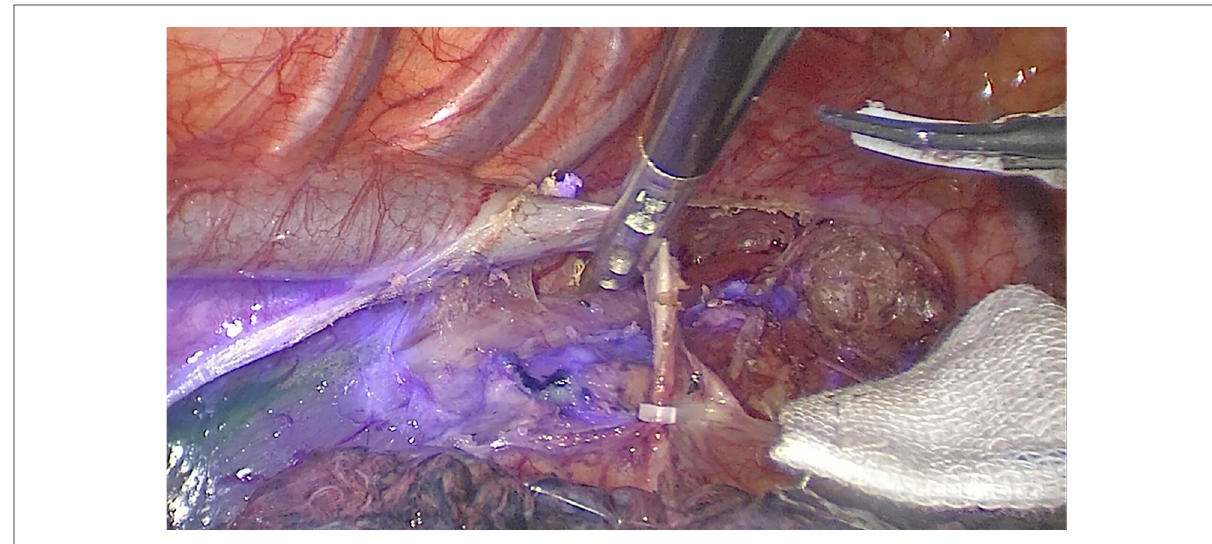
FIGURE 3 Signi fi cant NIR background directly on the esophageal specimen, particularly around the injection site.